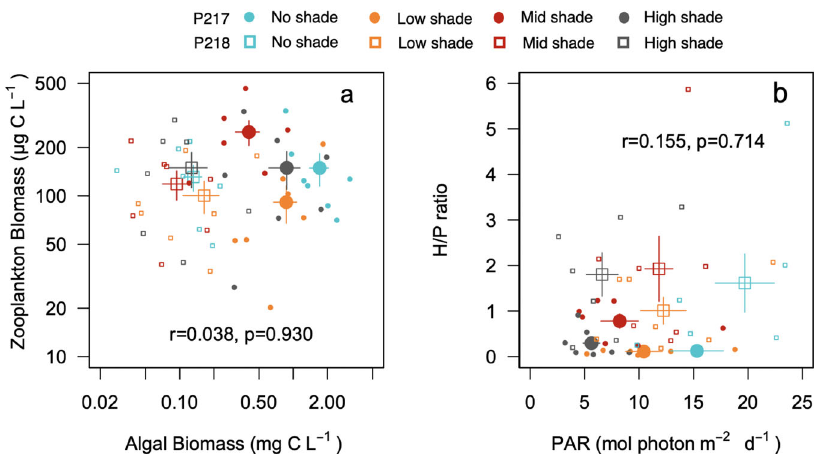
Fig. 2 Relationships between zooplankton biomass and phytoplankton biomass, and between H/P mass ratio and photosynthetic active radiation. Biplots of zooplankton biomass ( μ g C L − 1 ) and phytoplankton biomass (mg C L − 1 ) ( a ) and H/P mass ratio and photosynthetic active radiation (PAR, mol photon m − 2 d − 1 ) ( b ) in the water column during the experiment in no-shade (blue), low-shade (orange), mid-shade (red), and high-shade (gray) treatments in pond 217 (circles) and 218 (squares). In each panel, small symbols denote values at each sampling date, and large symbols denote the mean values among the sampling dates. Bars denote standard errors on the means ( n = 7 sampling date in each section). Correlation coef fi cients ( r ) with p values between the mean values are inserted in each